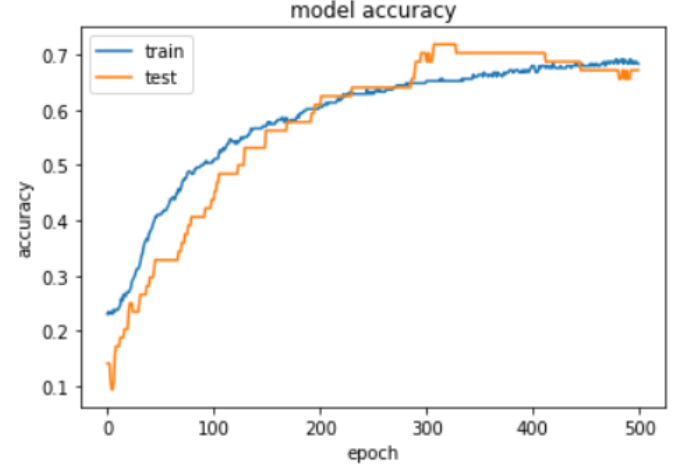
Figure 9. BPNN accuracy